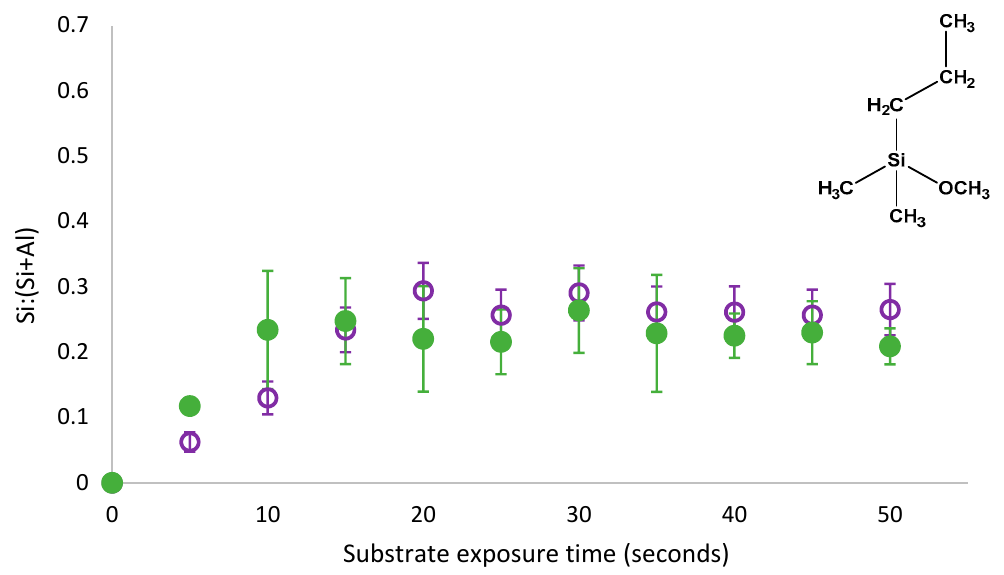
Figure 3. Langmuir-type adsorption of 1% PDMMS in 1:1 EtOH:H 2 O solvent at pH3 on aluminium foil substrates, measured using XPS. Upon removal from solution, samples films were either dried with N 2 (solid green circles) [8] or rinsed with pH 3 CH 3 COOH (open purple circles) prior to drying and cured.